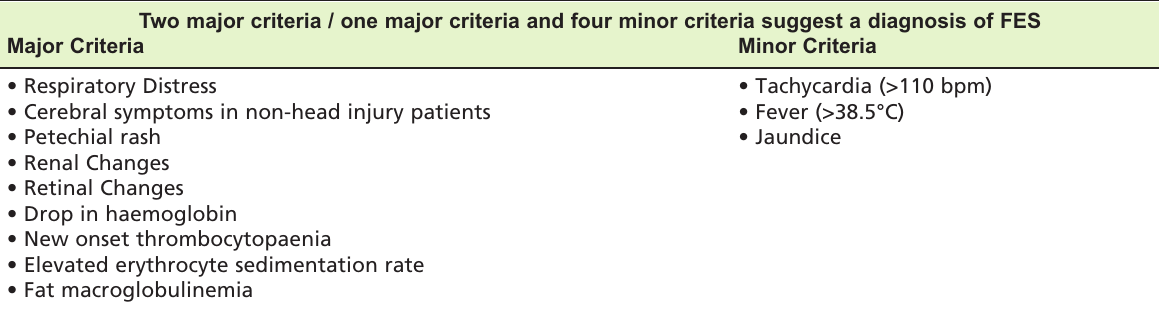
Schonfeld’s scoring system for diagnosing FES 6 Table III: Score >5 points diagnoses FES Sign/ Symptom: